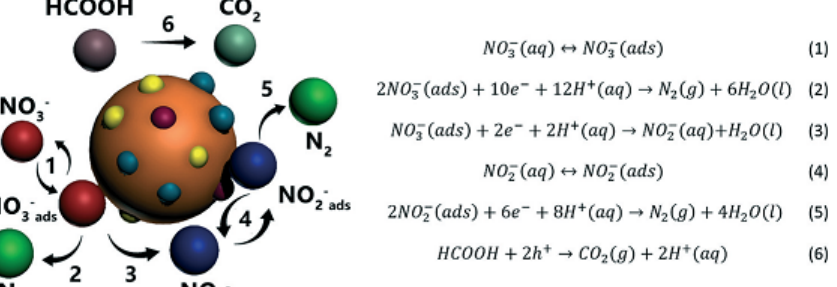
Figure 16. Photocatalytic nitrate reduction on CuInS 2 loaded with co-catalysts in the presence of sacrificial agents. The abbreviations (aq), (ads), and (g) mean ions in an aqueous solution, adsorbed on the surface and in the gas form, respectively. Reproduced with permission from ref. [120]. Copyright 2016 Royal Society of Chemistry.